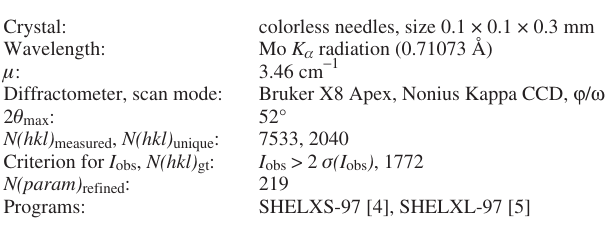
Table 1. Data collection and handling.